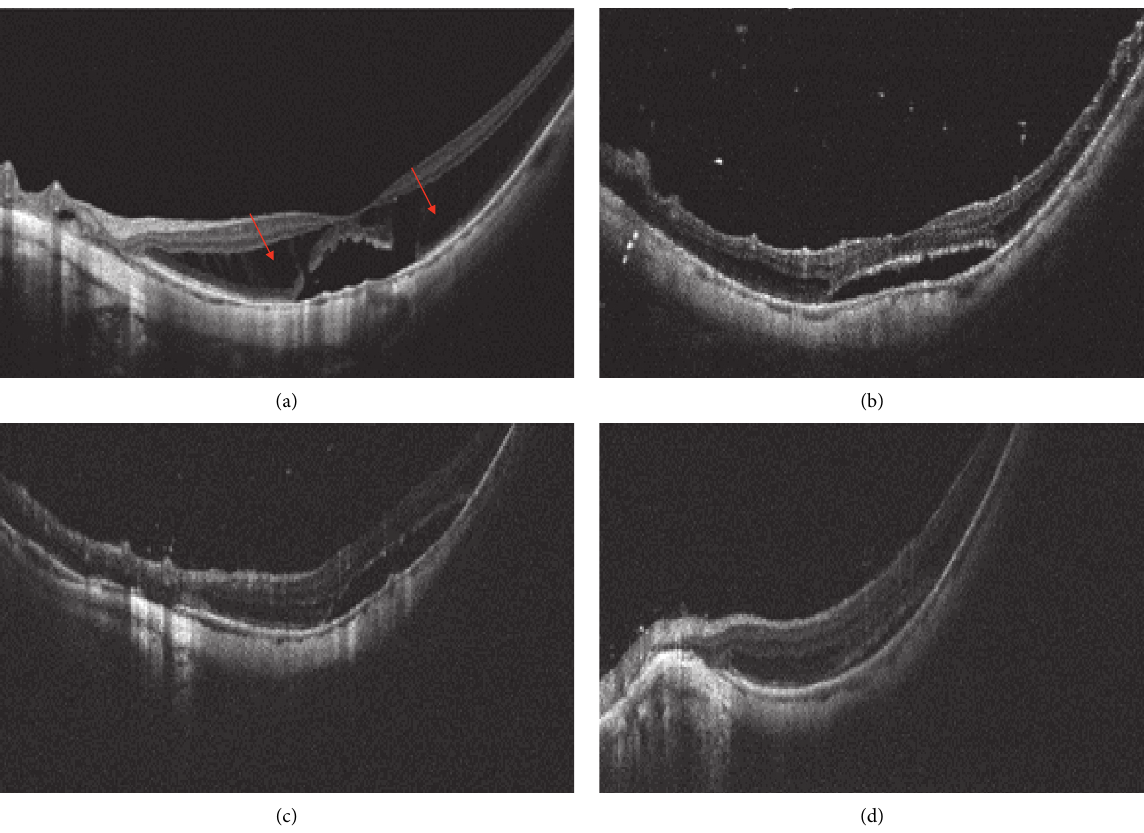
Figure 3: Pre and postoperative representative OCTimages of simple myopic foveoschisis. Preoperative image shows the splitting of inner retinal layer with column-like formations (red arrow), and the CFT and BCVA were 493 μ m and 1.5, respectively (a). At 1 month after operation, the CFT was 466 μ m (b). At 3 months after operation, the CFT was 359 μ m (c). At 6 months after operation, the CFTand BCVA were 324 μ m and 0.5, respectively